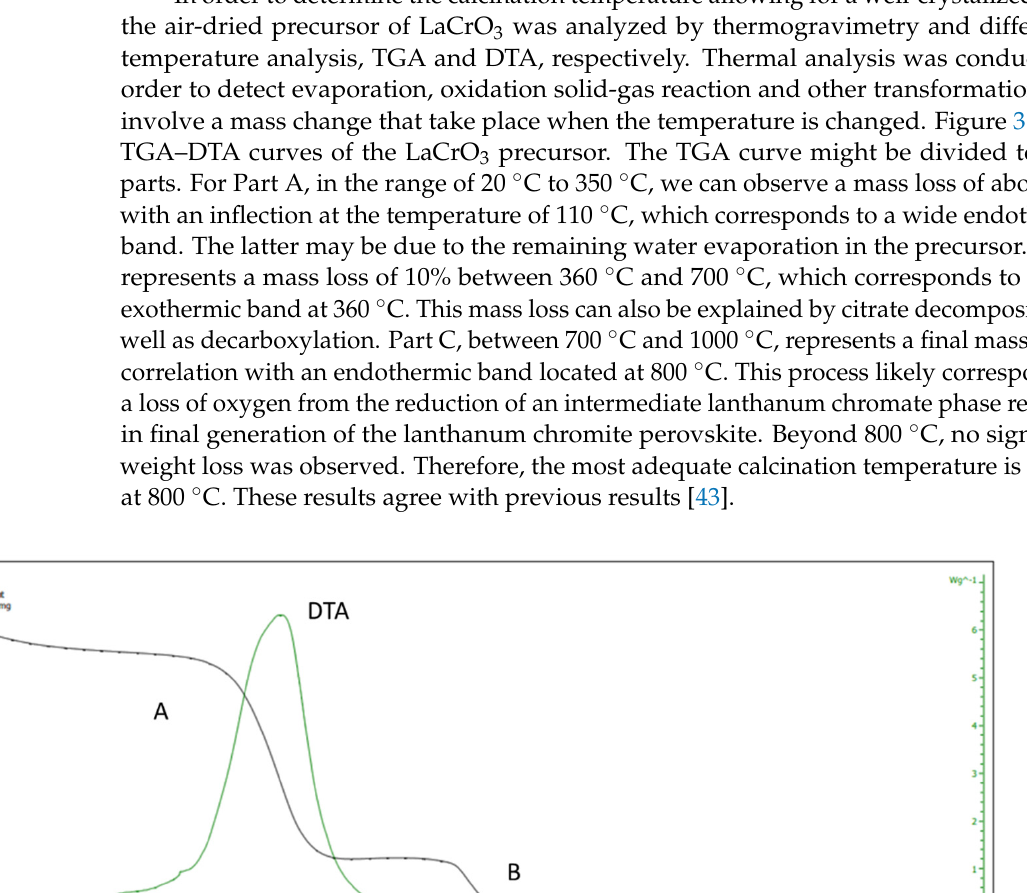
Figure 4. XRD and refinement pattern of LaCrO (cid:2871) . Figure 5. Field Emission Scanning Electron Micrographs of LaCrO (cid:2871) before and after hydrogenation ( a , b ) respectively.